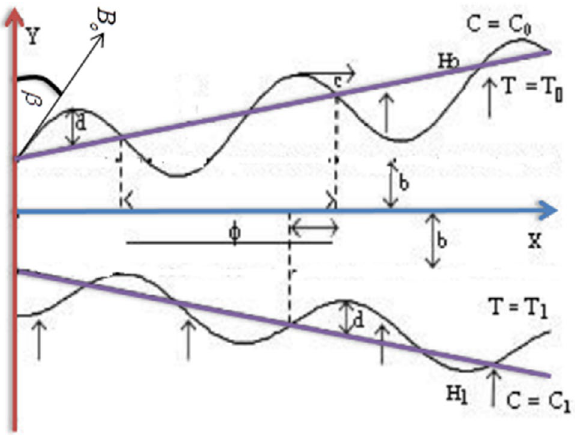
Figure 1. Schematic of the